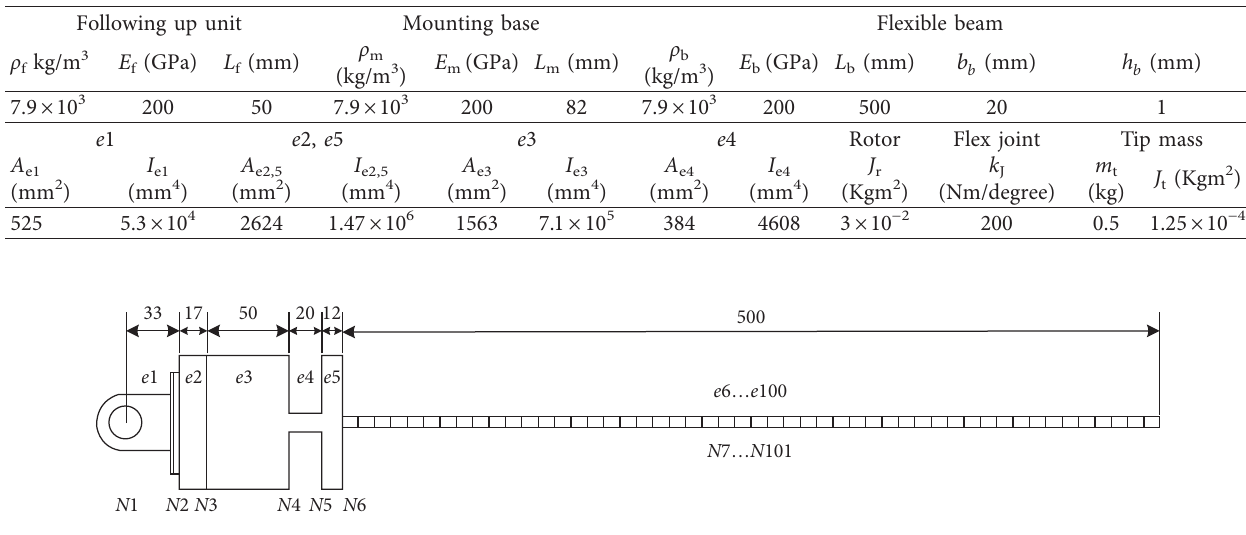
Figure 2: Elements of flexible components.